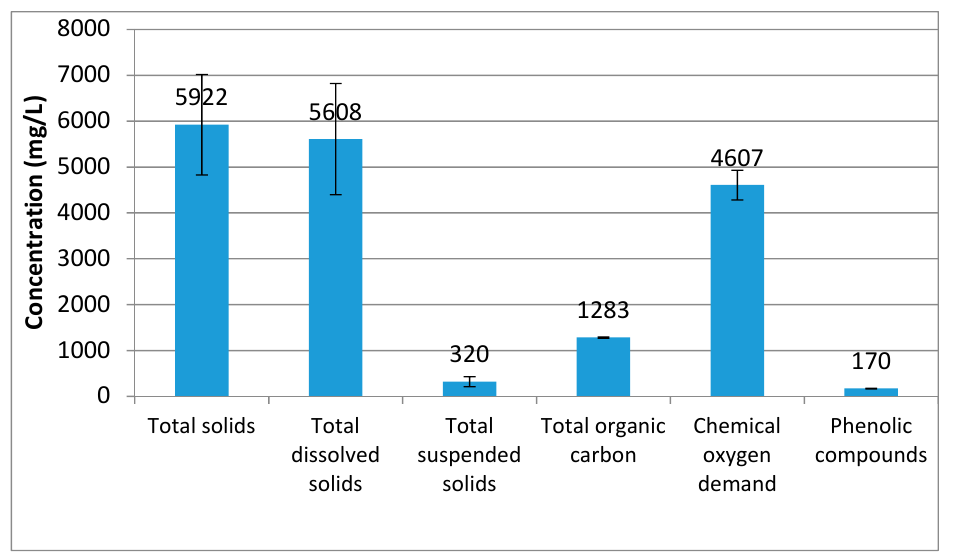
Figure 1. Characterization of the olive mill wastewater in terms of total solids, total dissolved solids, total suspended solids, total organic carbon, chemical oxygen demand and phenolic compounds; error bars present variation of wastewater characteristics measured in different sampling events. Table 1. Volatile compounds detected in the feed samples. Compound % Similarity Compound